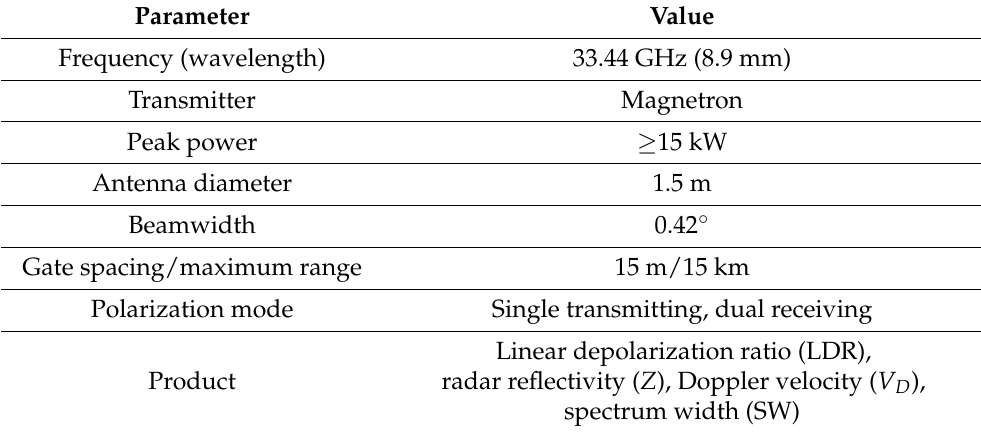
Table 1. Specifications of the Ka-band cloud